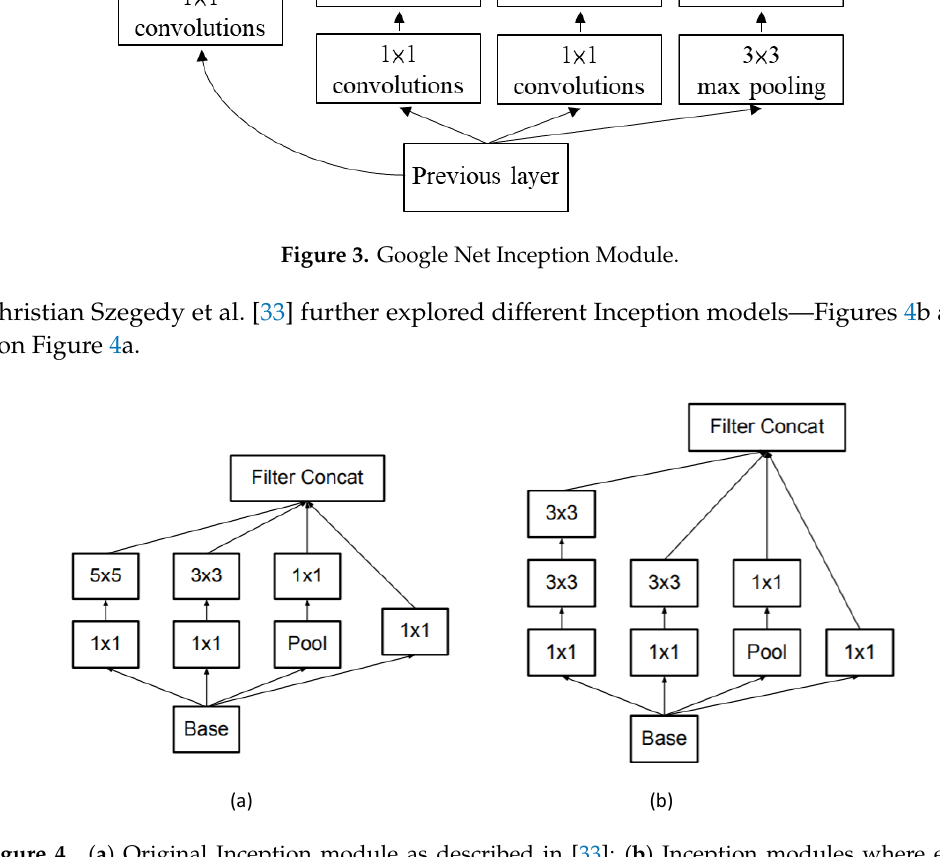
Figure 4. ( a ) Original Inception module as described in [33]; ( b ) Inception modules where each 5 × 5 convolution is replaced by two 3 × 3 convolutions. Electronics 2020 , 9 , x FOR PEER REVIEW